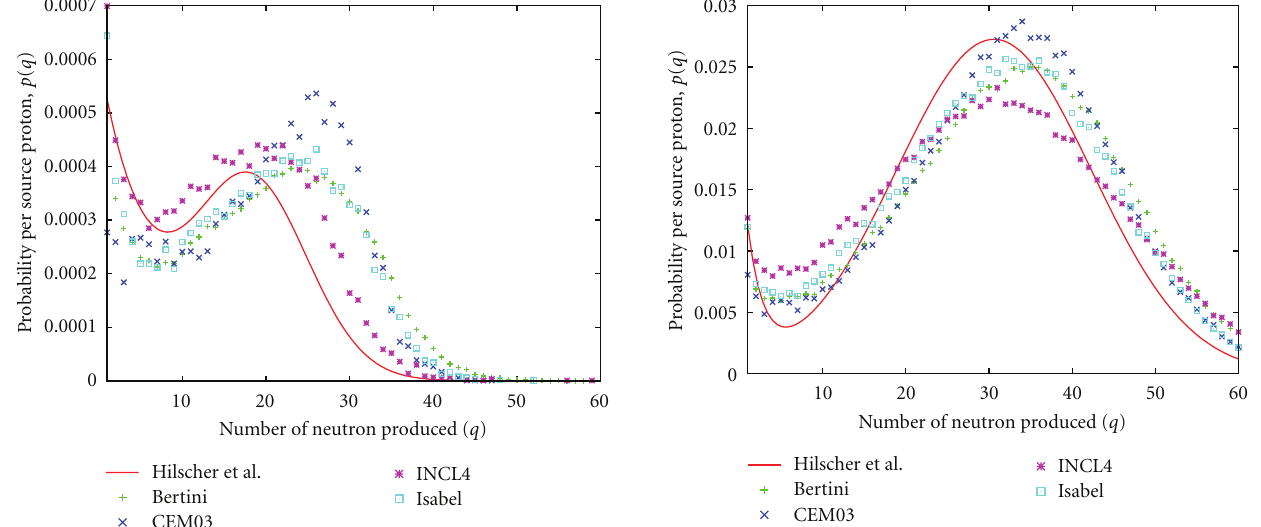
Figure 3: Comparison of measured and simulated distribution of the number of neutrons produced by a source proton for the 0.2 cm thick target.